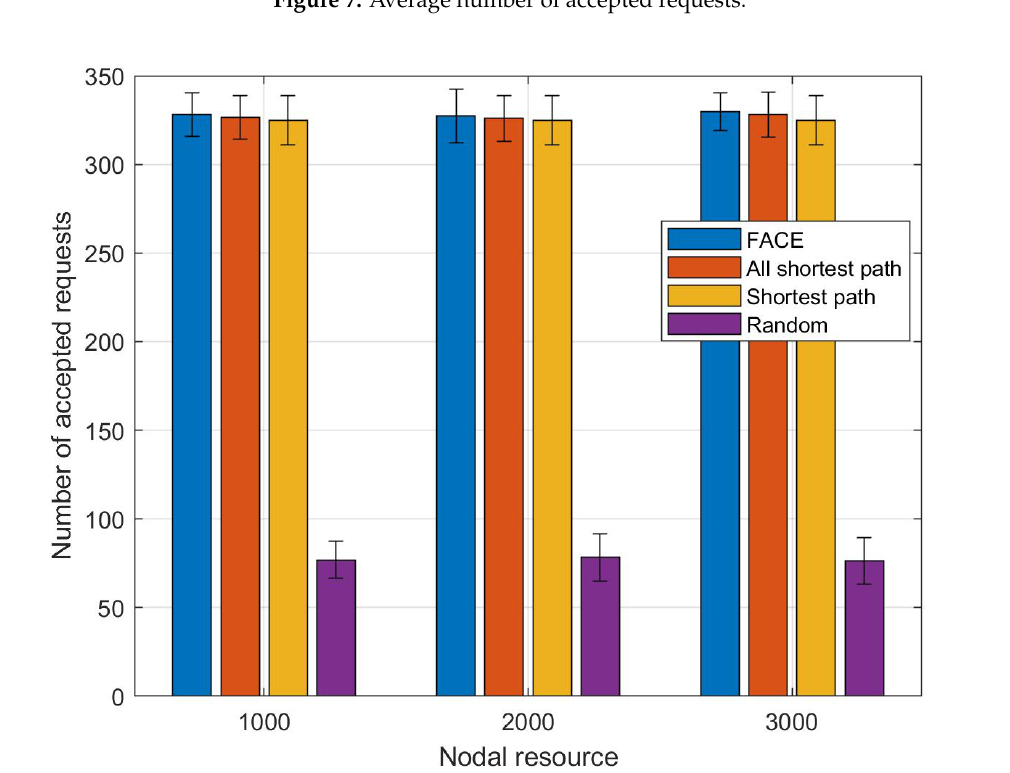
Figure 8. Average number of accepted